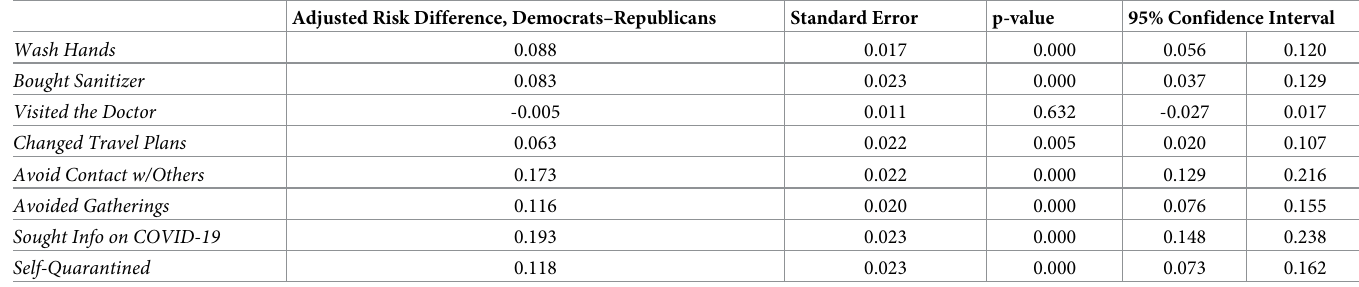
Table 2. Adjusted risk differences, health behaviors. This table reports the adjusted risk differences for eight health behaviors. These are the differences between Republi- cans and Democrats from the statistical models in Fig 1 (S3 Table in S1 File), adjusting for all other covariates. Adjusted Risk Difference,